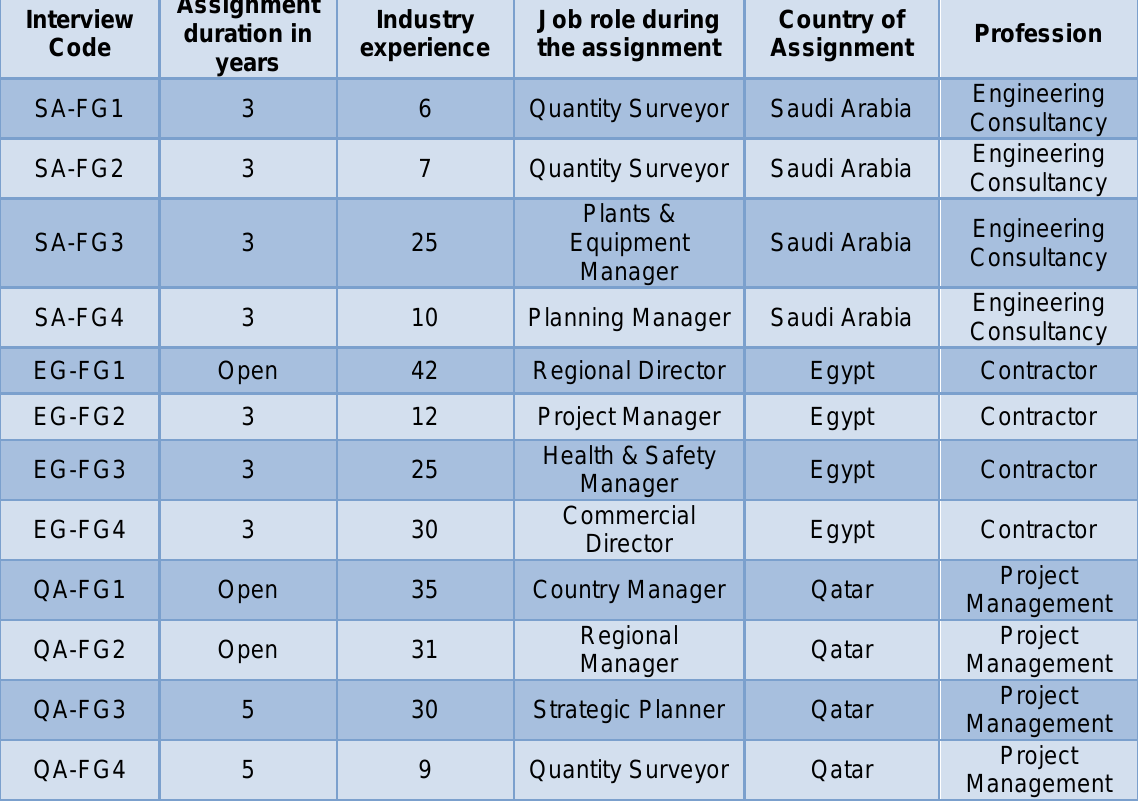
Table 1 Respondents profile for focus group